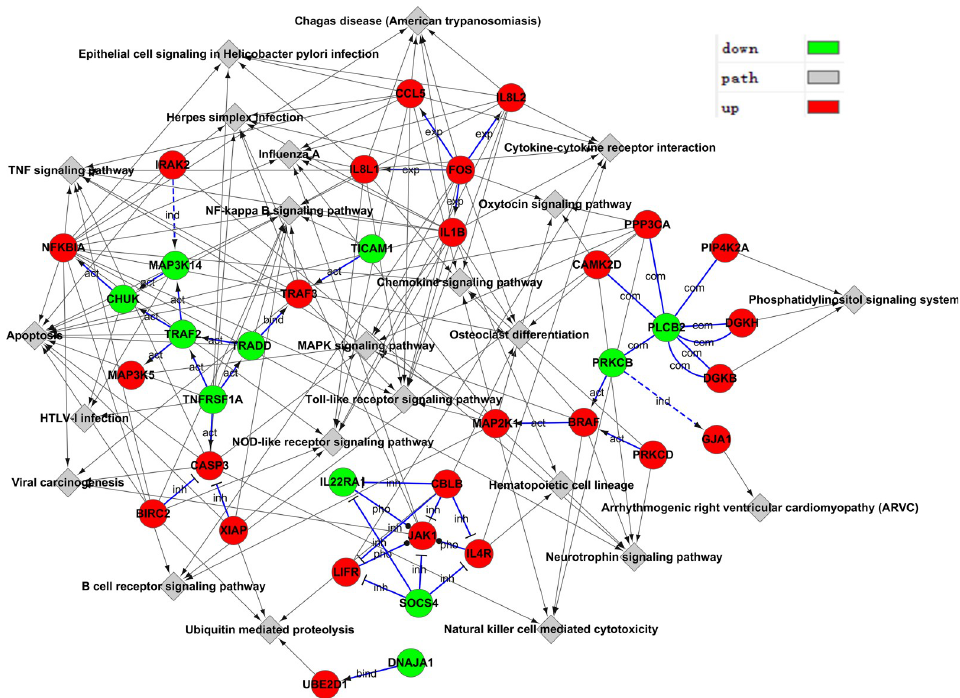
Fig 5. Gene-Act network of differential genes according to pathways in the database. Red dots represent up- regulated genes and green dots represent down-regulated genes. The arrows indicate the connection and regulatory relationship between two genes. Genes that have more connections with other genes have a higher degree